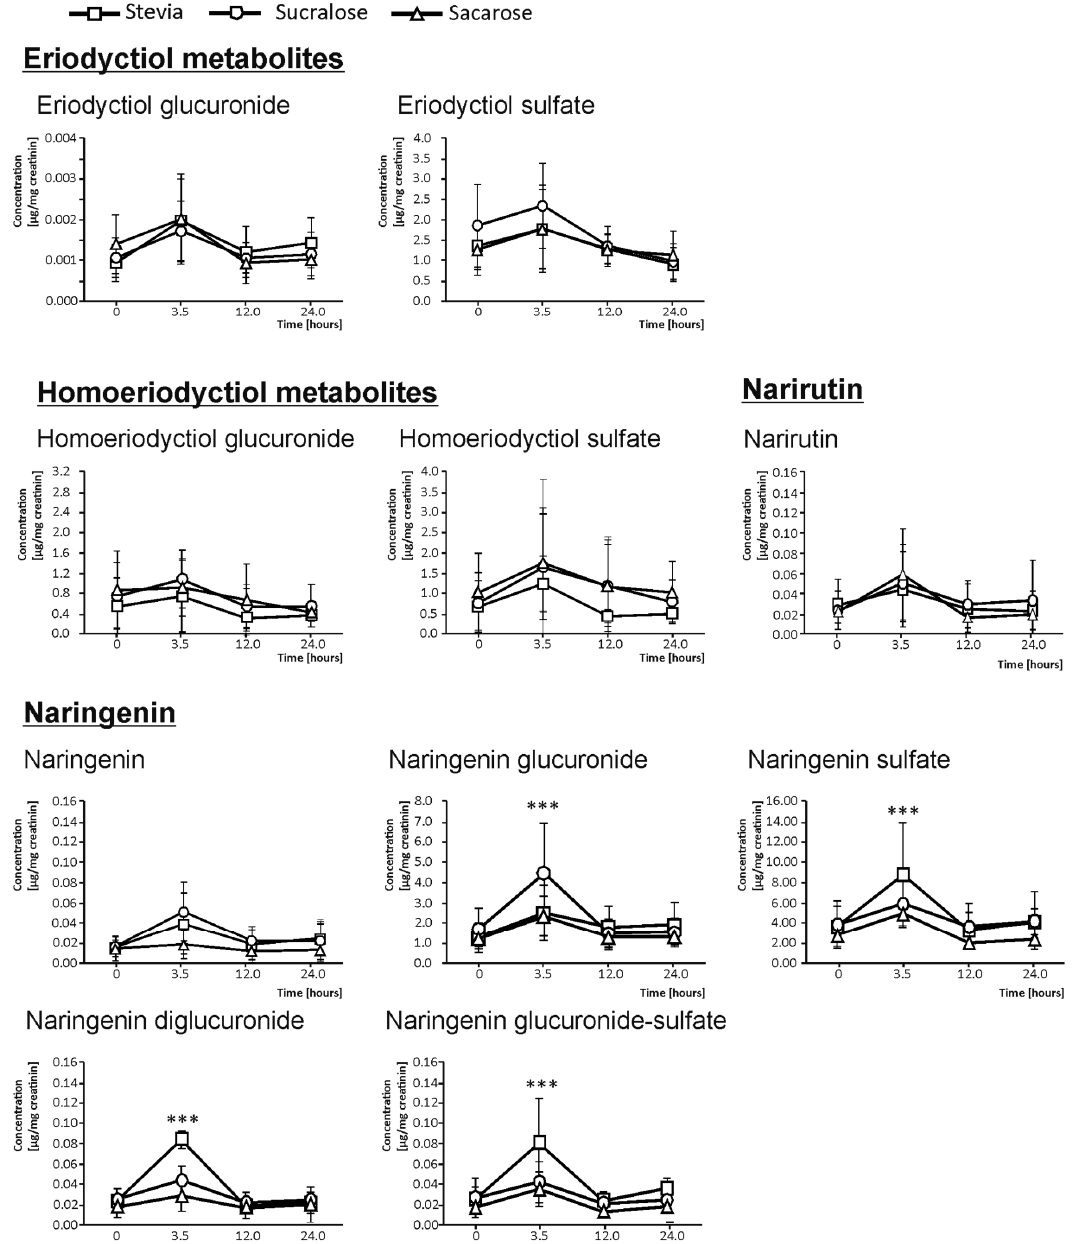
Figure 1. Content (mean ± SD, n = 2) of single flavanone metabolites in basal urine and 3.5, 12, and 24-h urine of healthy volunteers after ingesting 330 mL of maqui-citrus juices developed using as sweeteners stevia ( ∆ ), sucralose (O), and sucrose ( □ ). Significantly different bioavailabilities according to an analysis of variance (ANOVA) and Duncan’s multiple rank test were found at p < 0.001 (***).